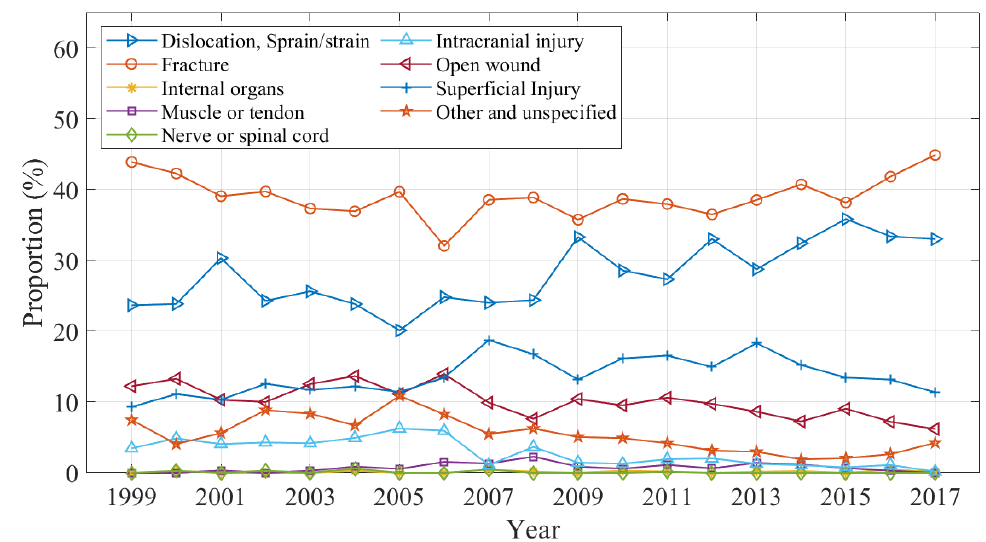
Figure 4. Proportion of injuries by nature.